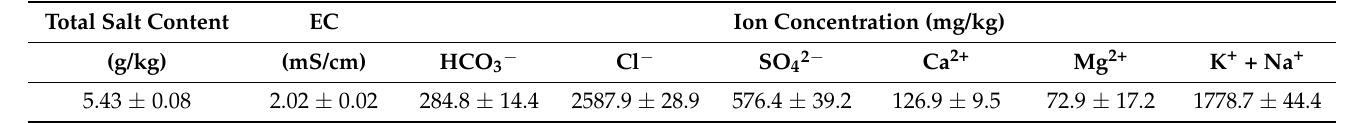
Table 2. The soil salinity and ion